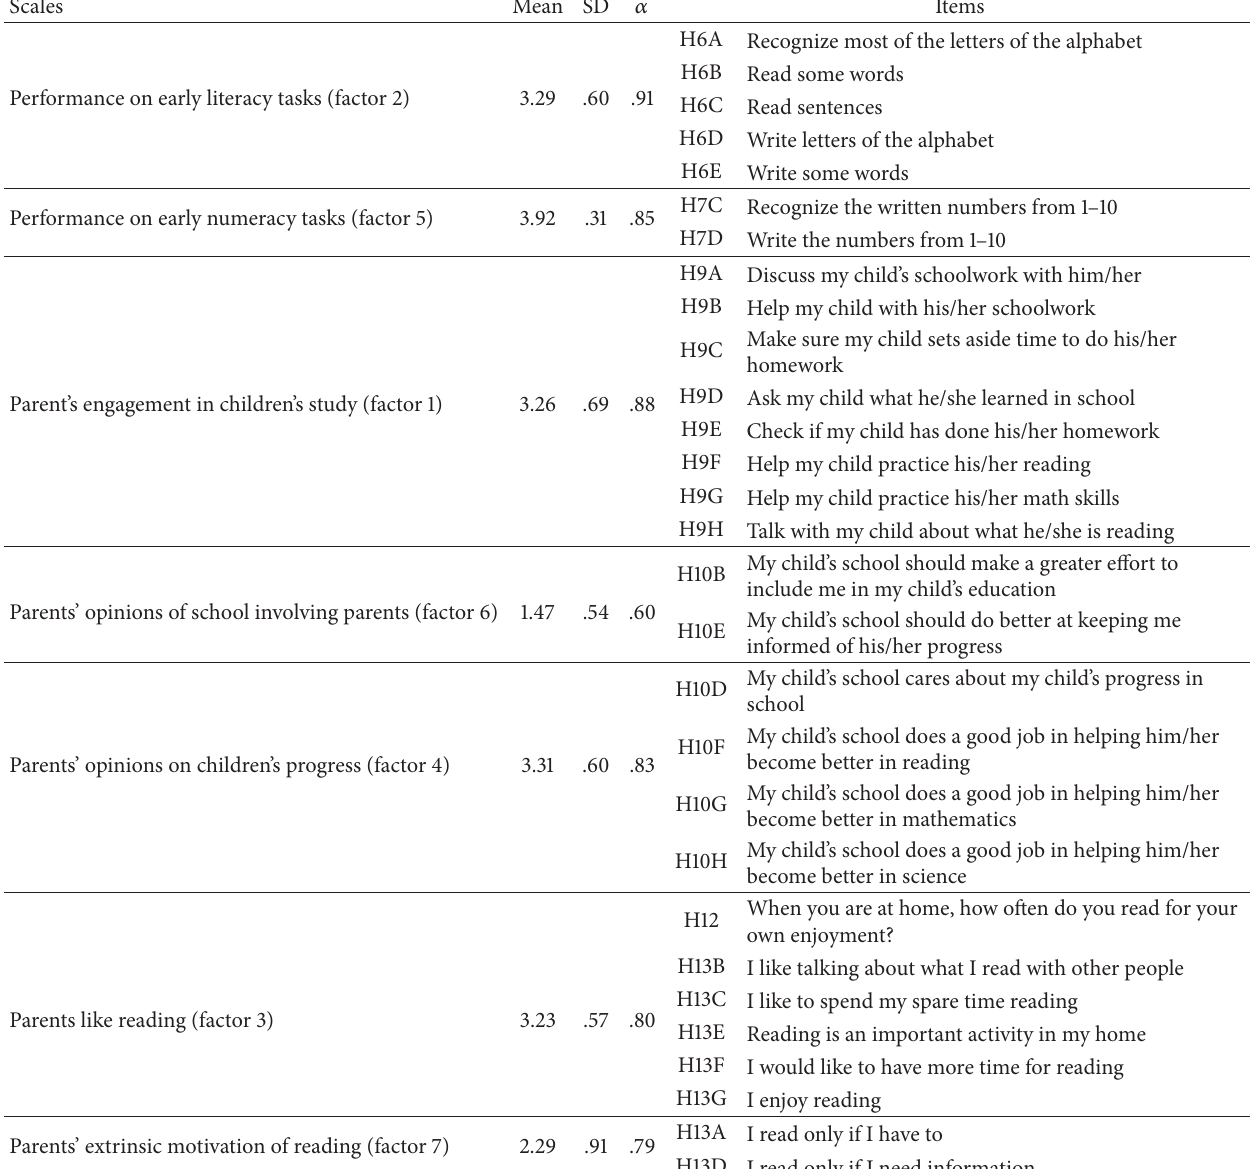
Table 3: Descriptive statistics of the 7-factor structure of the PIRLS 2011 home questionnaire.